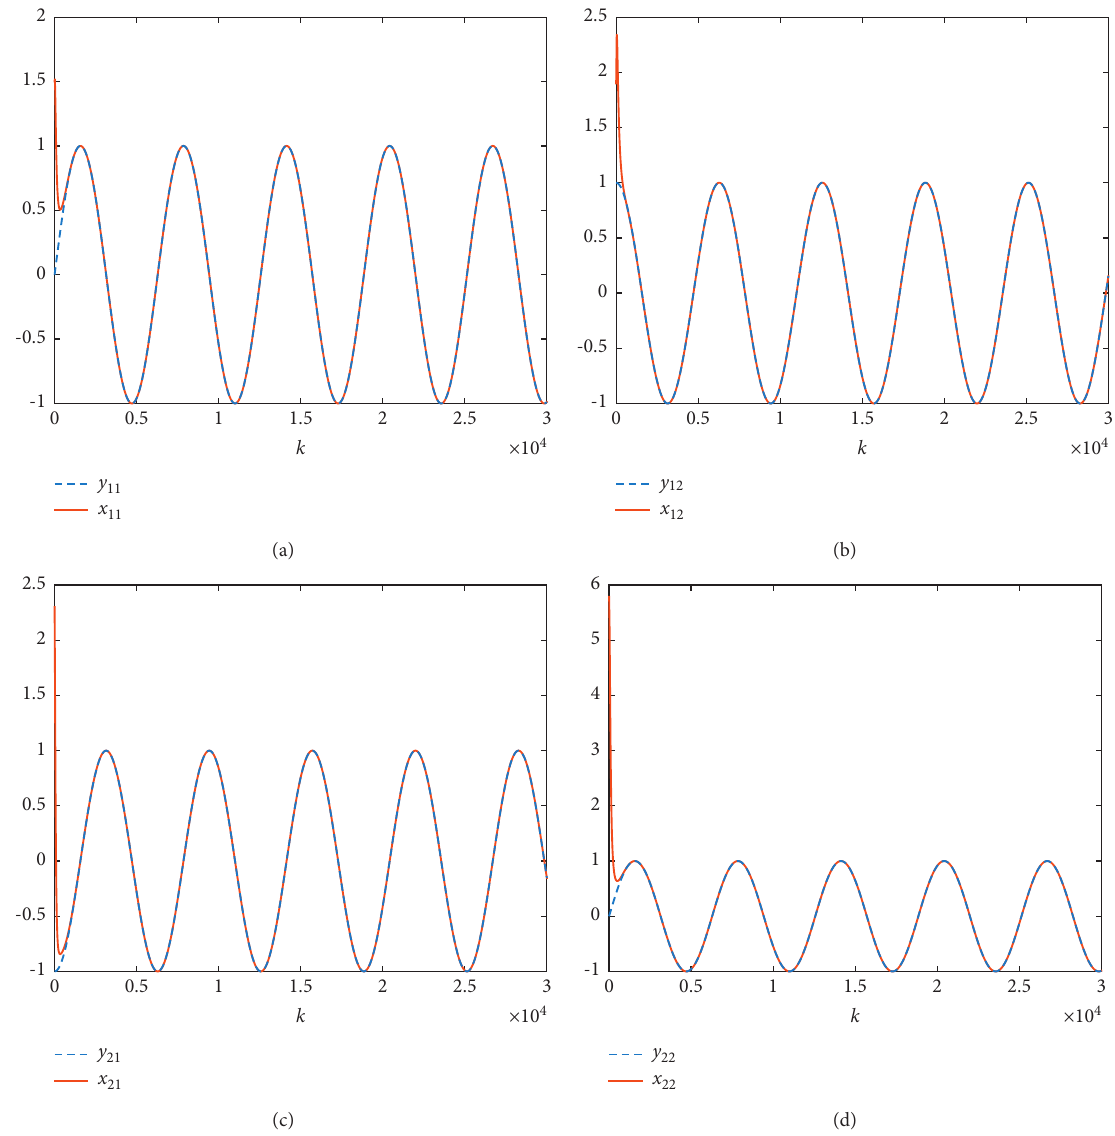
Figure 4: Solution trajectories synthesized by Y c � 5 . 0). (a) Trajectories of y